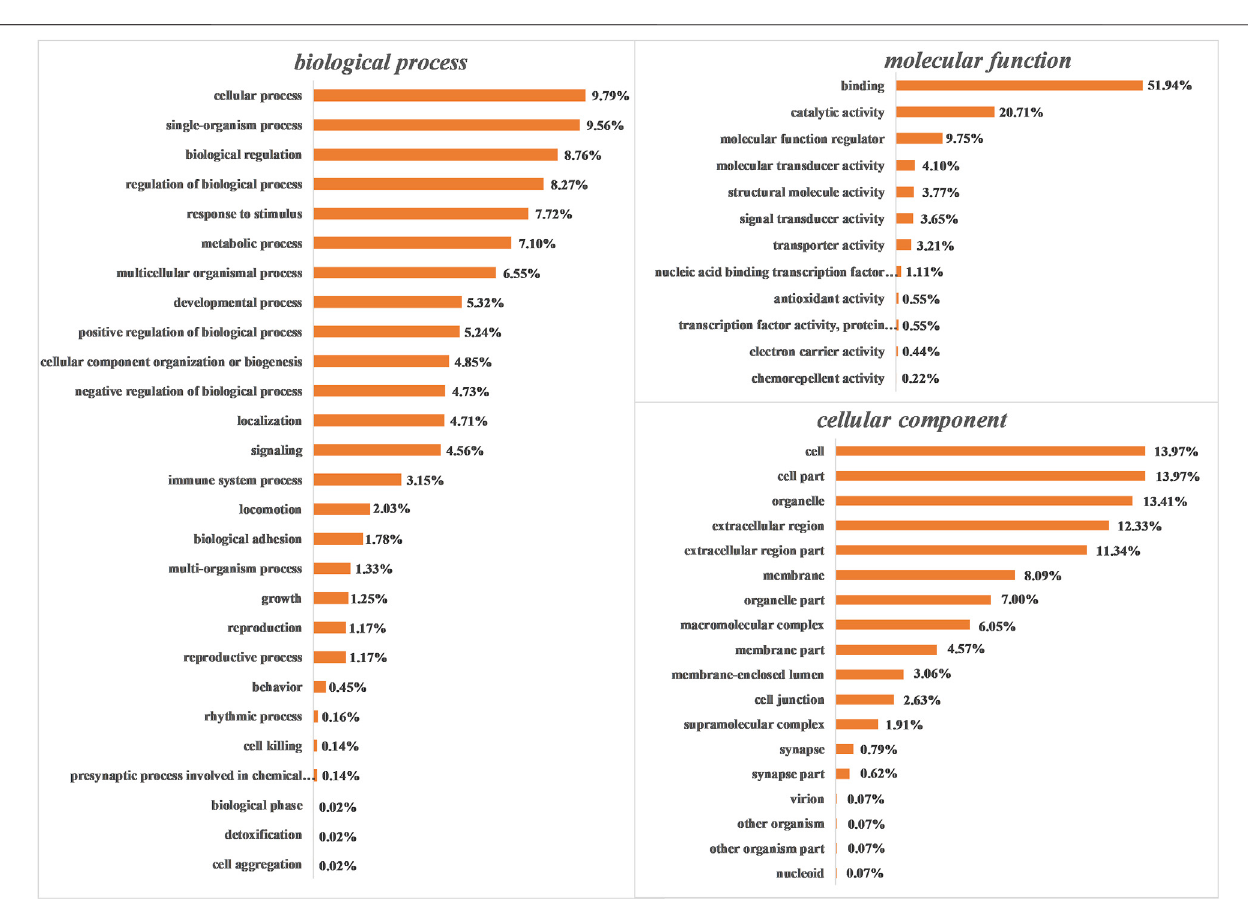
FIGURE 4 | Gene ontology (GO) analysis of all differentially expressed proteins (DEPs). Proteins were classi fi ed according to biological process (BP), molecular function (MF), and cellular component (CC) by Blast2GO software (version 3.3.5).